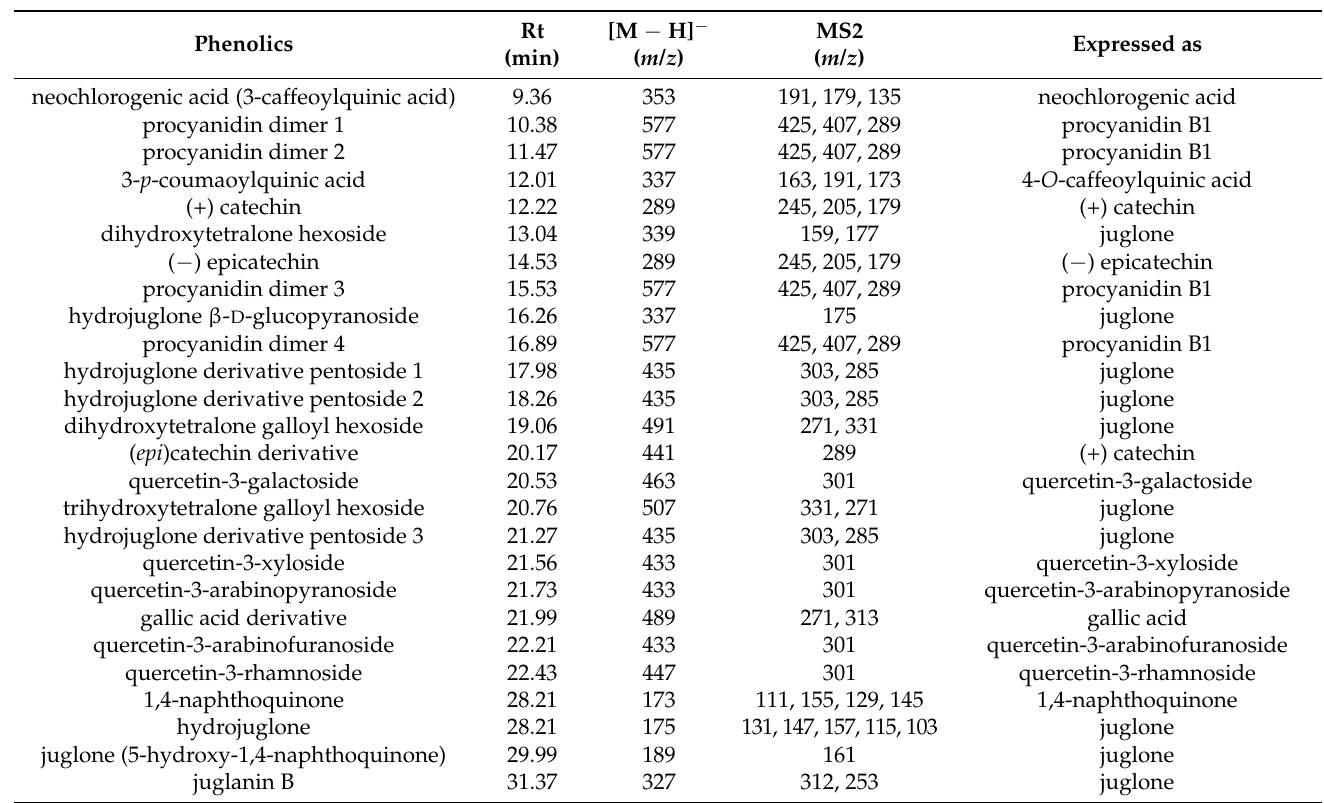
Table 1. Tentative identification of 26 phenolic compounds from the husk of Juglans regia L., and the standard compounds they are expressed